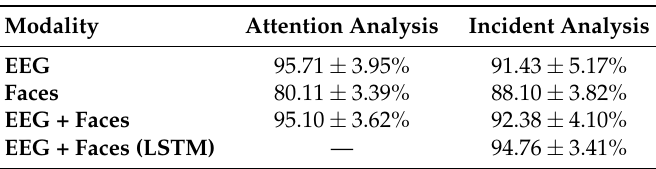
Figure 11. Multi-modality classification performance for driver attention during hazardous/non- hazardous incidents. Table 2. Single vs. Multi-Modality Performance